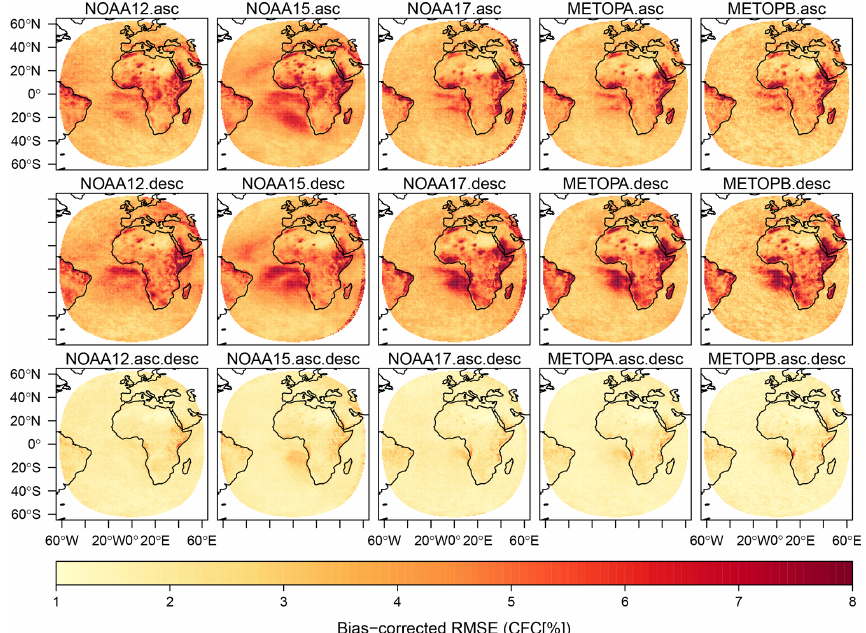
Figure 9. Bias-corrected root mean square error of CFC caused by the discrete sampling of the CFC diurnal cycle, presented for each morning (AM) NOAA satellite and each node (asc – ascending, desc – descending, and asc.desc – ascending and descending